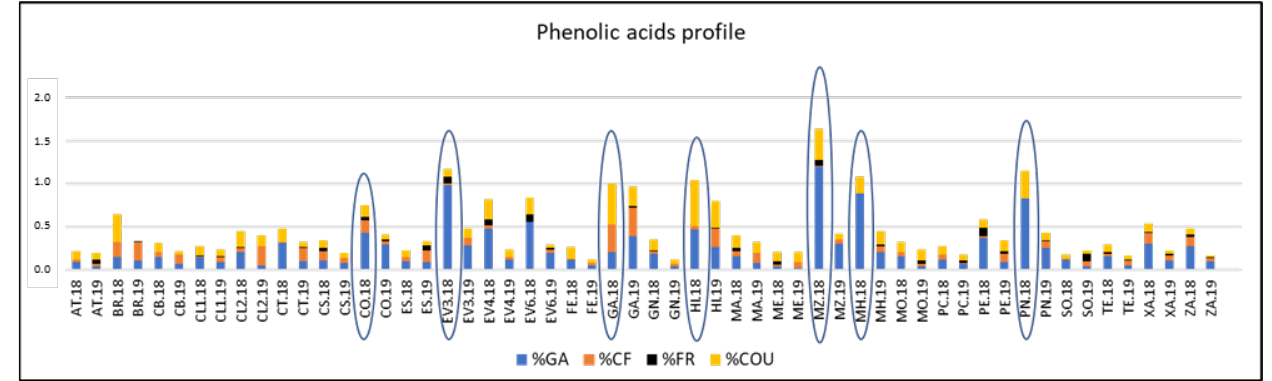
Figure 4. Phenolic acids profile respect to the total polyphenol content of varieties from the EVEGA germplasm bank in 2018 and 2019 vintages. % CF; % COU; % GA and % FR are percentages of caffeic acid, coutaric acid, gallic acid and ferulic acid, respectively. See Table 1 for varieties abbreviations.